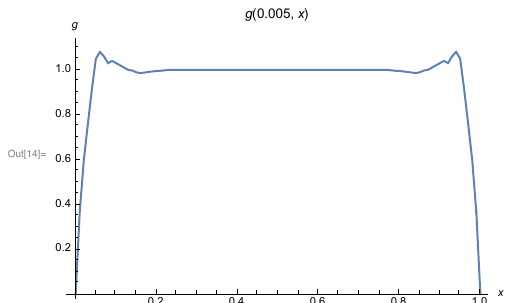
Figure 7. Normal solution g ( γ = 0 . 005 , x ) of eq. (10) with the kernel (11) vs. x for the same parameters as in Fig. 5